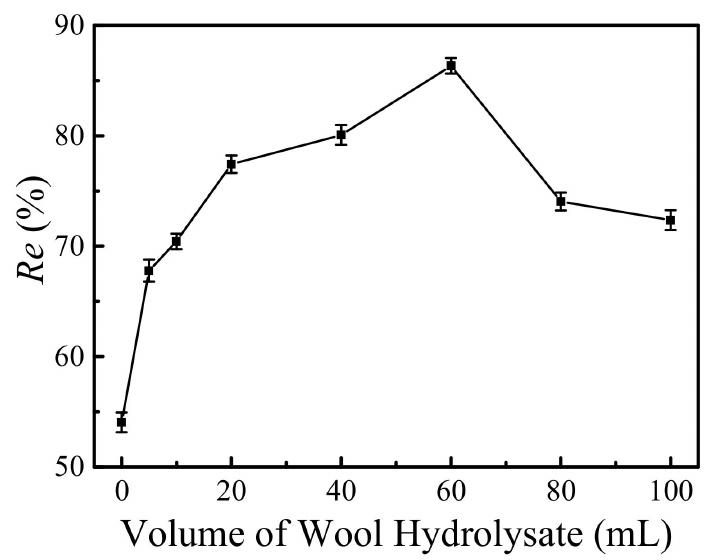
Figure 8. The effects of the volumes of wool keratin hydrolysates on the removal efficiencies of Cu 2+ ions by the wool keratin modified Fe 3 O 4